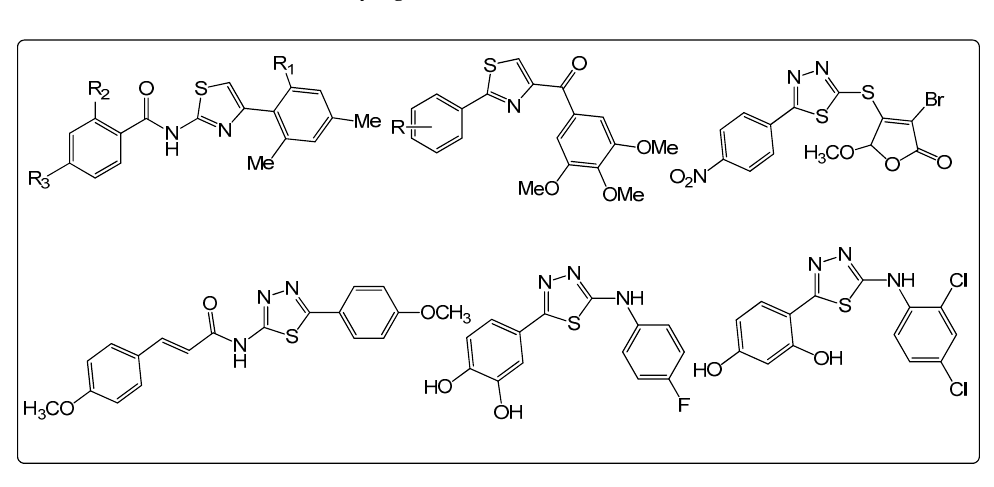
Figure 1. Lead compounds among thiazole and thiadiazole derivatives with anticancer activity.